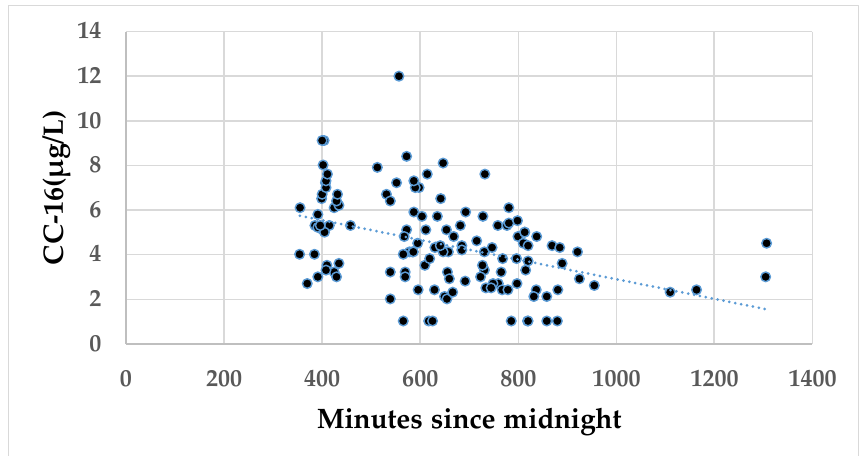
Figure 1. The association between the serum concentrations of club cell protein 16 (CC-16) at baseline and time of blood sampling in minutes after midnight among all participants. The following regression equation was calculated: CC-16 = 7.3 (6.2 to 8.5) − 0.004 ( − 0.006 to − 0.003) minutes since midnight. The 95% confidence intervals are shown in brackets. Pearson’s r = − 0.41; p < 0.001. Int. J. Environ. Res. Public Health 2019 , 16